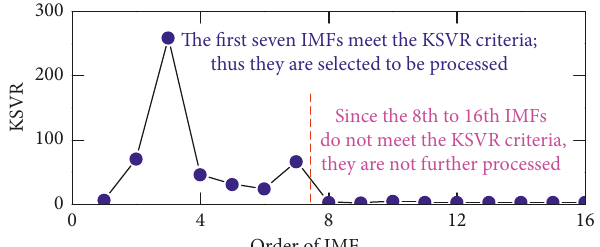
Figure 11: Kurtosis of the SVR spectra of the IMFs obtained by